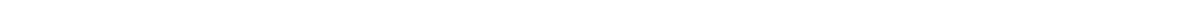
Fig. 8 Migratory cDCs and macrophages are more ef fi cient than pDCs for clonal deletion, a process accentuated on a Lt α − / − background. a Experimental setup: Lt α − / − recipients were injected with cell-sorted cDCs, pDCs or macrophages from Ccr2 RFP/ + heterozygous mice. The thymic localisation of these cell types was analysed three days later on thymic sections. b Thymic sections were stained with antibodies against the medulla speci fi c marker K14 (magenta) and CD11c (green), BST-2 (green) or F4/80 (green). Adoptively transferred RFP + cells were detected in red. m and c denote the medulla and the cortex, respectively. The graph shows the ratio of medullary vs. cortical density of adoptively transferred cells. Twenty- fi ve sections derived from two mice for each genotype were quanti fi ed for each condition. Scale bar: 100 µ m. c CCR2 and MHCII in BM-derived cDCs, pDCs and macrophages from WT mice were analysed by fl ow cytometry. Histograms show the MFI values of CCR2 and MHCII expression normalised to the FMO value of each population analysed. Data are representative of two independent experiments ( n = 3 mice per group and per experiment). FMO fl uorescence minus one, MFI mean − / − or fl uorescence intensity. d Experimental setup: AT of puri fi ed OVA 323 – 339 -loaded BM-derived cDCs, pDCs or macrophages into OTII- Rag2 OTII- Rag2 − / − x Lt α − / − recipients. Clonal deletion was analysed 3 – 5 days after AT. e Numbers of total thymic cells, DP and V β 5 + V α 2 + CD4 + SP cells were analysed for each condition. UT untreated OTII- Rag2 − / − mice. Data are representative of three independent experiments ( n = 4 mice per group and per experiment). M Φ macrophage. Error bars show mean ± SEM, * p < 0.05, ** p < 0.01, *** p < 0.001, **** p < 0.0001 using unpaired Student ’ s t -test for b ,